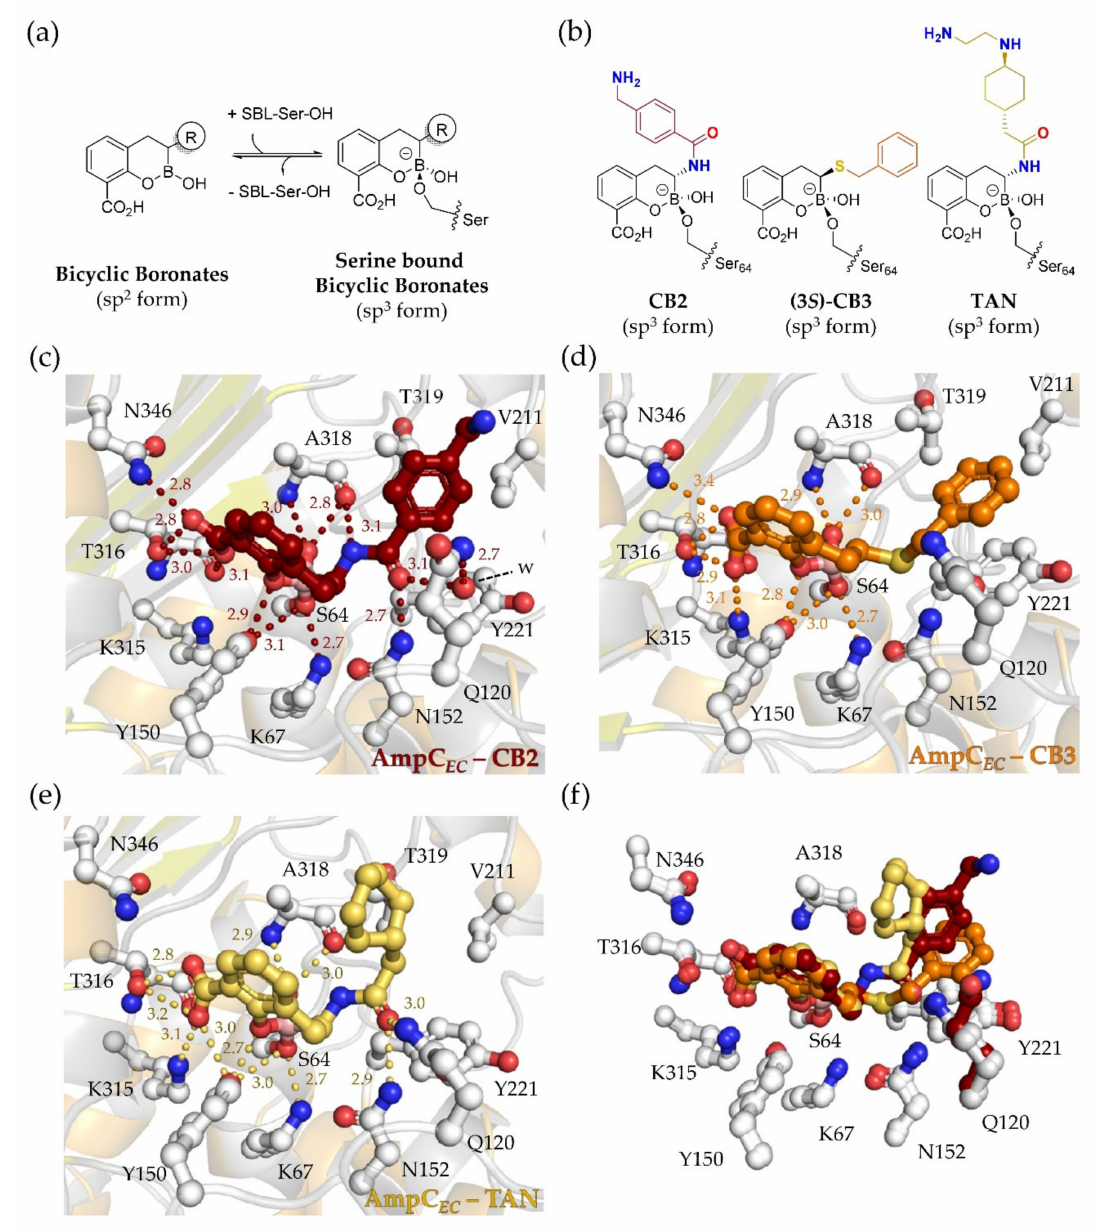
Figure 2. Structural basis for AmpC EC inhibition by bicyclic boronates. ( a ) reaction between sp 2 -hybridized bicyclic boronates and SBLs give a serine-bonded anionic sp 3 -hybridized species; ( b ) structures of serine-bonded sp 3 forms of the bicyclic boronates; ( c – e ) active site views of complexes of AmpC EC with CB2, CB3, and TAN. Hydrogen-bonding interactions are shown in colored dashes, distances are in Å; ( f ) overlay of active site views, color coding as in ( c – e ). Note that the Q120 side chain is rotated in AmpC EC -CB2 structure (highlighted in dark red); it is unclear whether this is induced by binding of CB2, or due to the crystallization conditions (see